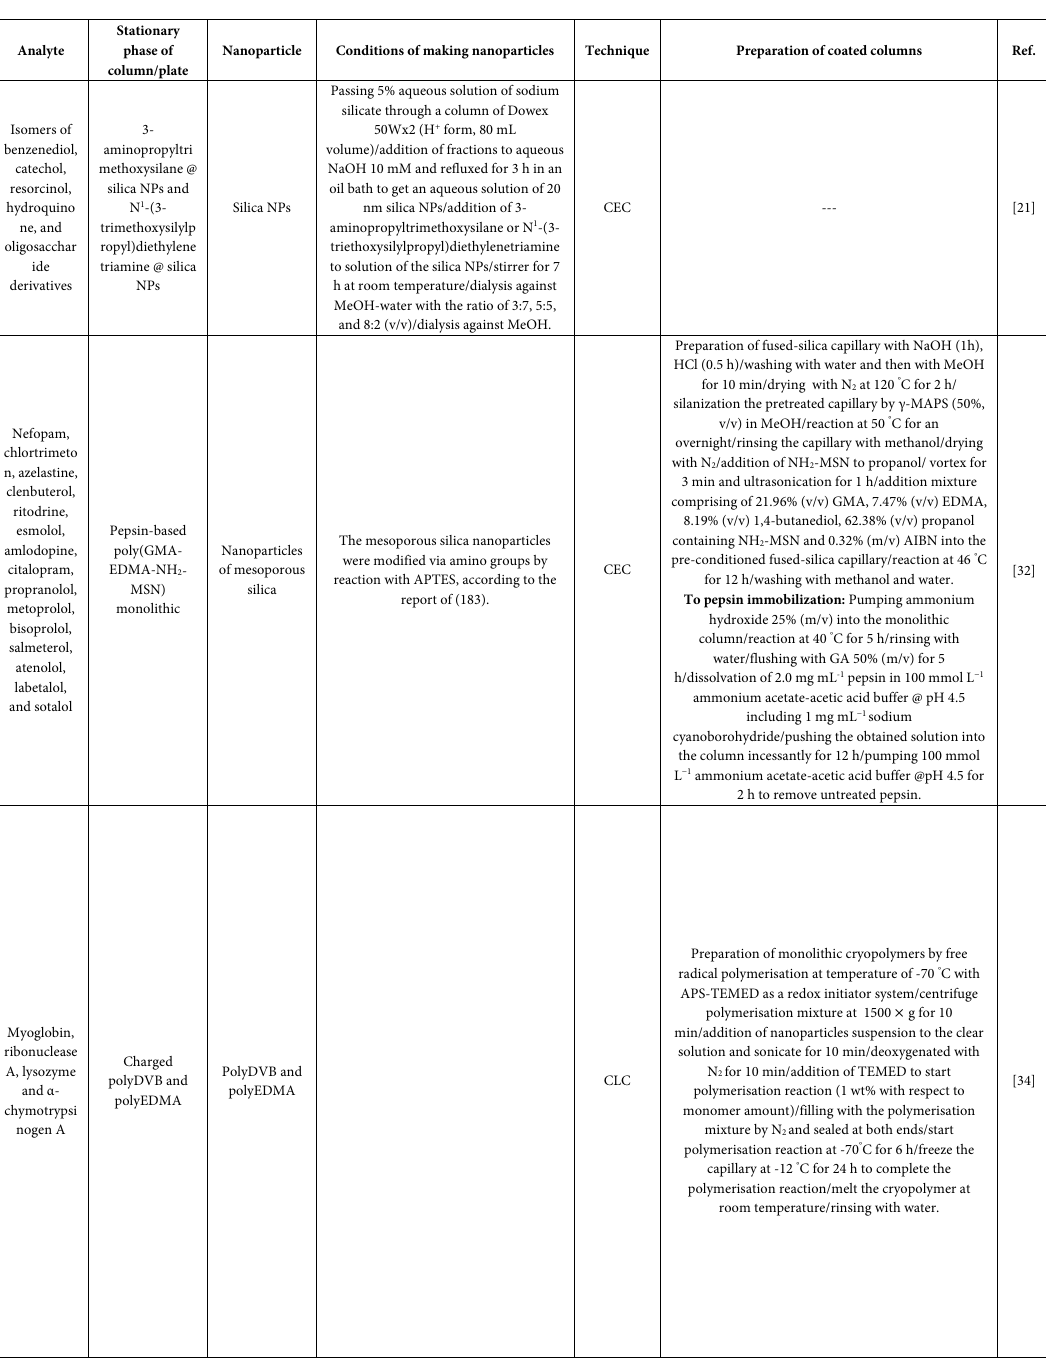
Table 1. Description of nano-stationary phases of analytical Table 1: Description of nano-stationary phases of analytical techniques. Technique Preparation of coated columns Ref.